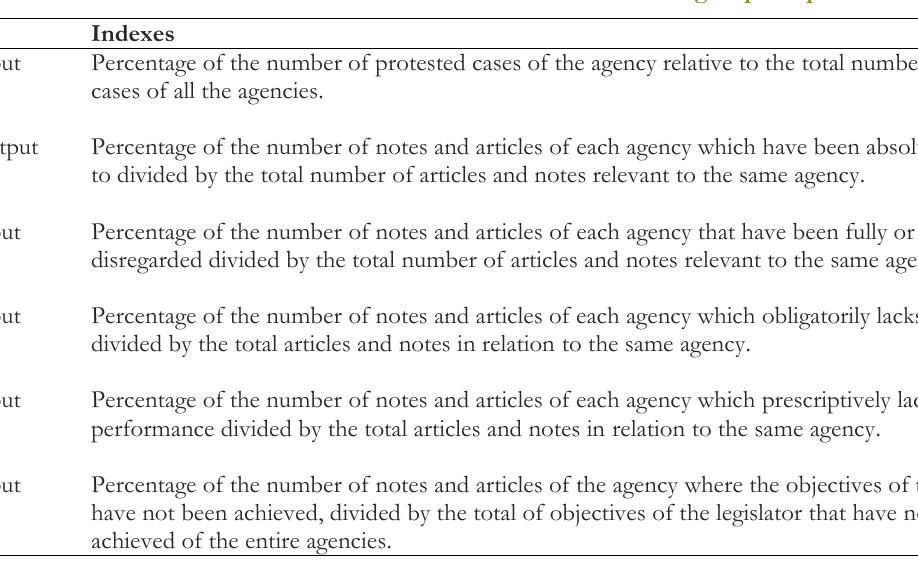
Table 1. Indexes extracted from the audit court budget split